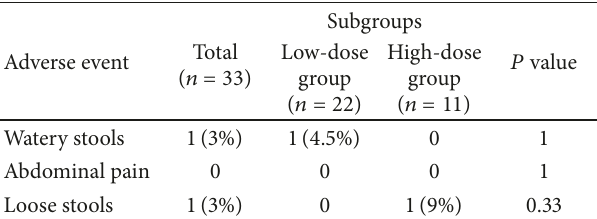
Table 2: Side effects of Daikenchuto